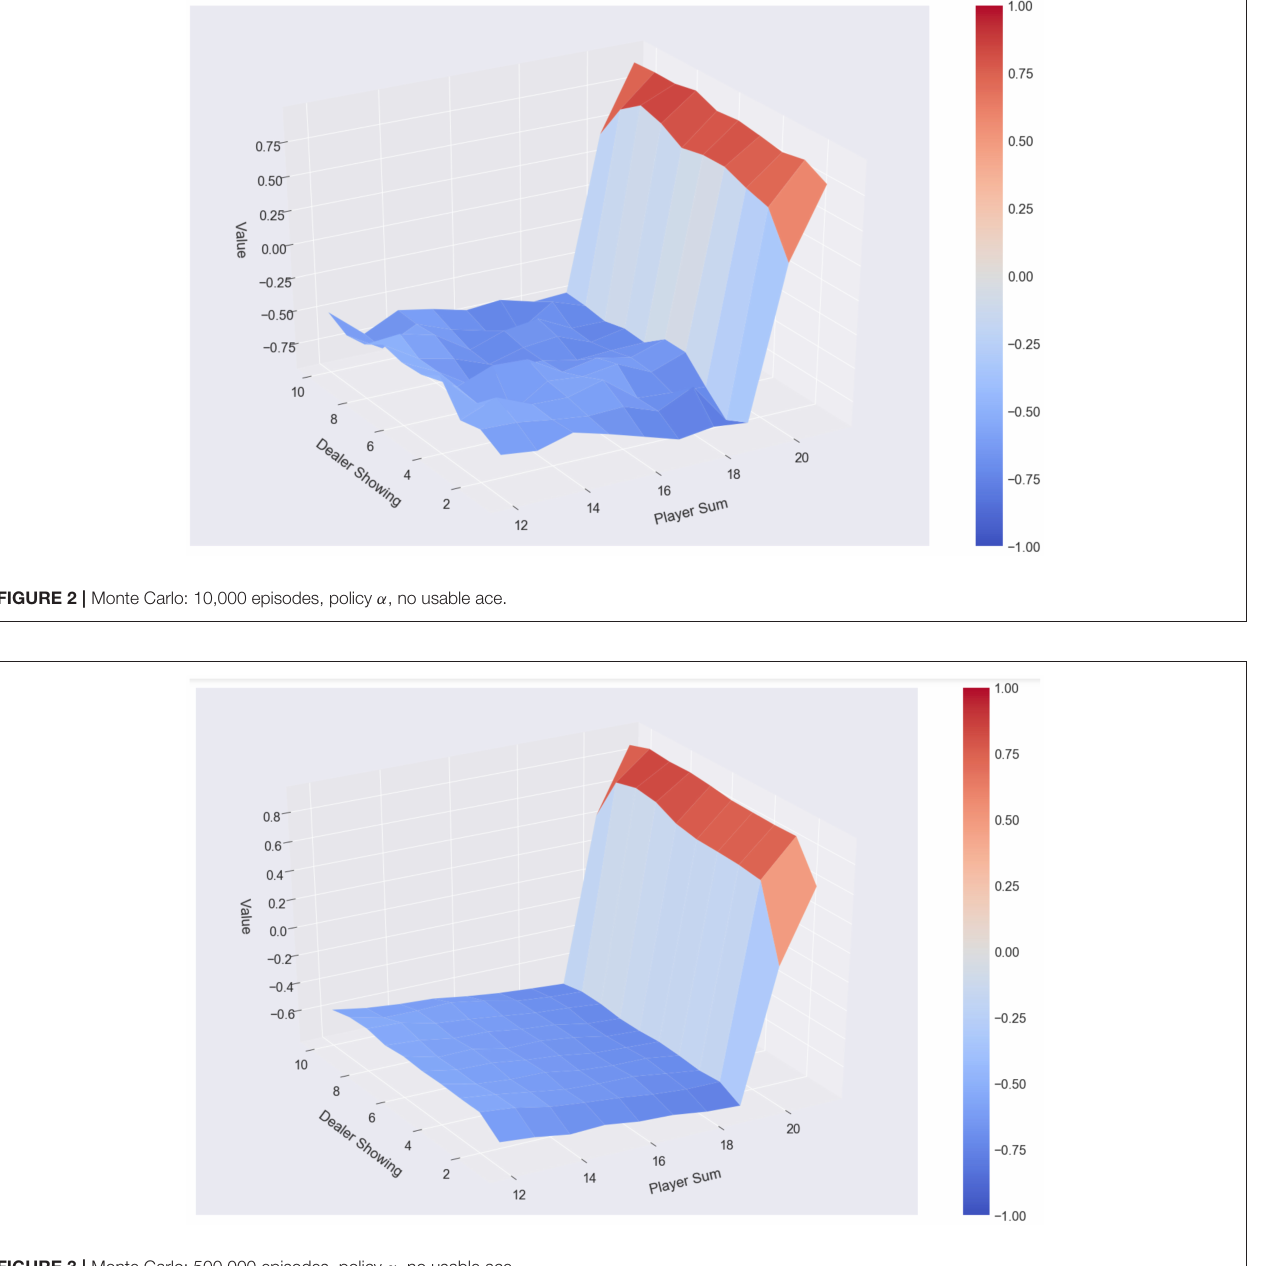
FIGURE 3 | Monte Carlo: 500,000 episodes, policy α , no usable